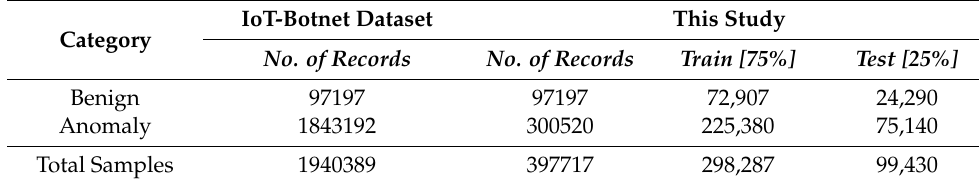
Table 1. IoT-Botnet 2020 Dataset Distribution.